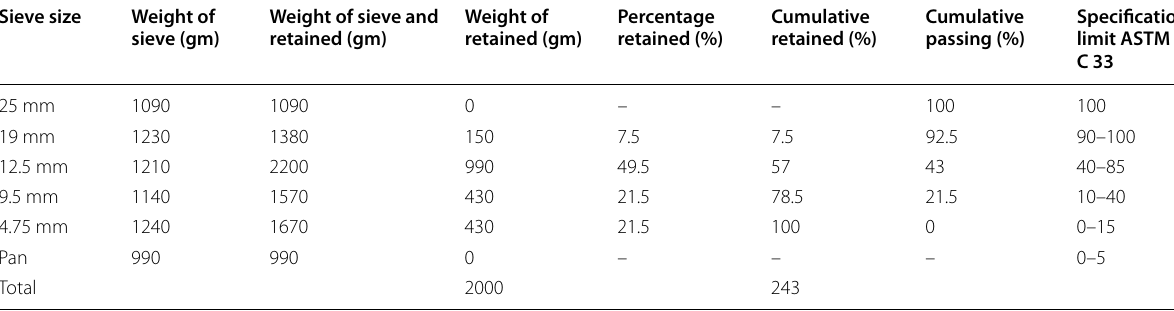
Table 9 Sieve analysis of coarse aggregate